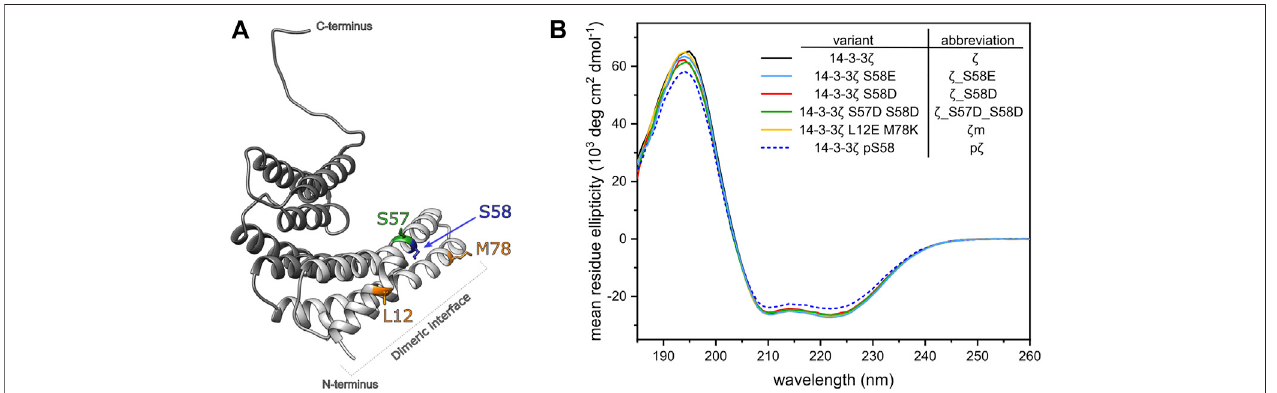
FIGURE 2 | Design and secondary structure analysis of 14-3-3 ζ phosphomimicking and monomeric mutants. (A) Structural model of the 14-3-3 ζ monomeric subunit with the modi fi ed residues highlighted in color. Helices forming the dimeric interface are depicted in light grey. Atom coordinates were adopted from Kostelecky et al. (2009) and Nagy et al. (2017). (B) Far-UV CD spectrum of 14-3-3 ζ variants. For clarity, 14-3-3 ζ variants, used in this study, and their abbreviations are listed in the